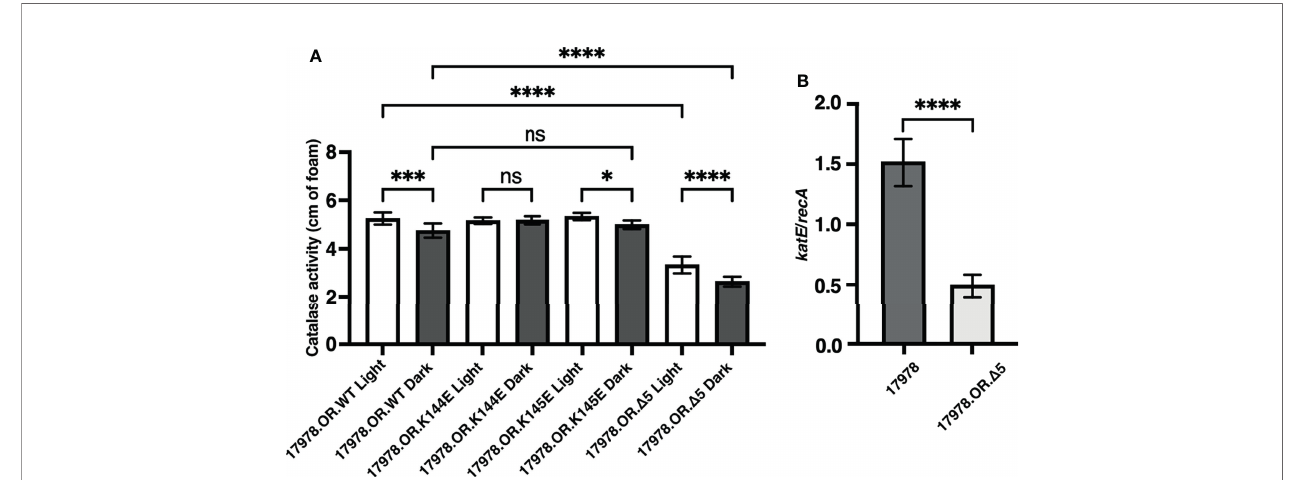
FIGURE 5 | The role of key BlsA amino acid residues in KatE regulation. (A) Catalase activity of the isogenic 17978 blsA mutant complemented with pMU368 derivatives encoding either wildtype BlsA (WT), the BlsA amino acid substitution derivatives K144E and K145E, or the BlsA deletion derivative D 5 was measured using culture samples representing equal numbers of bacteria that had been grown in SB under blue light or in darkness with shaking to exponential phase at 24°C. The catalase activity of each strain was analyzed using three independent biological replicates in technical triplicate ( n = 9). Error bars represent the standard deviations of the data sets. Horizontal bars with symbols indicate results of ordinary one-way ANOVA with Sidak ’ s multiple comparisons post-hoc test (* P ≤ 0.05; *** P ≤ 0.001; **** P ≤ 0.0001; ns, not signi fi cantly different). (B) Expression of katE in the wildtype 17978 strain (17978) or the 17978 blsA mutant complemented with the pMU368 derivative encoding the BlsA deletion derivative D 5 (17978.OR. D 5). katE expression was normalized to that of the constitutively expressed reference gene recA . This transcriptional analysis was carried out for each strain using two independent biological replicates, the fi rst analyzed in technical duplicate and the second analyzed in technical triplicate ( n = 5). Error bars represent the standard deviation of the data sets. Horizontal bar with asterisks indicates the result of unpaired t-test analysis (**** P ≤ 0.0001).